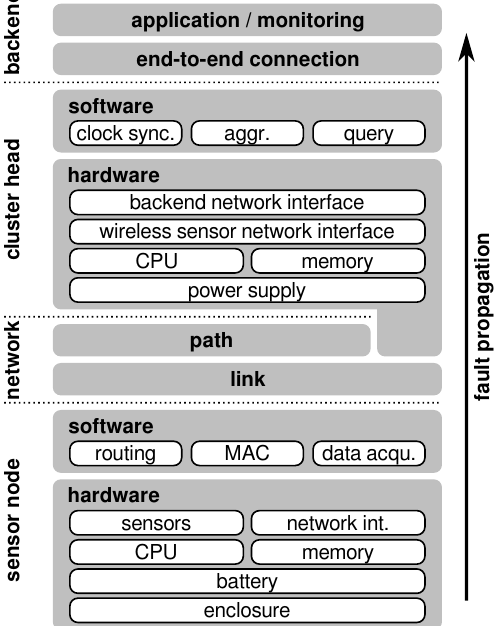
Figure 3. Fault propagation in a wireless sensor network (after Figure 1 in